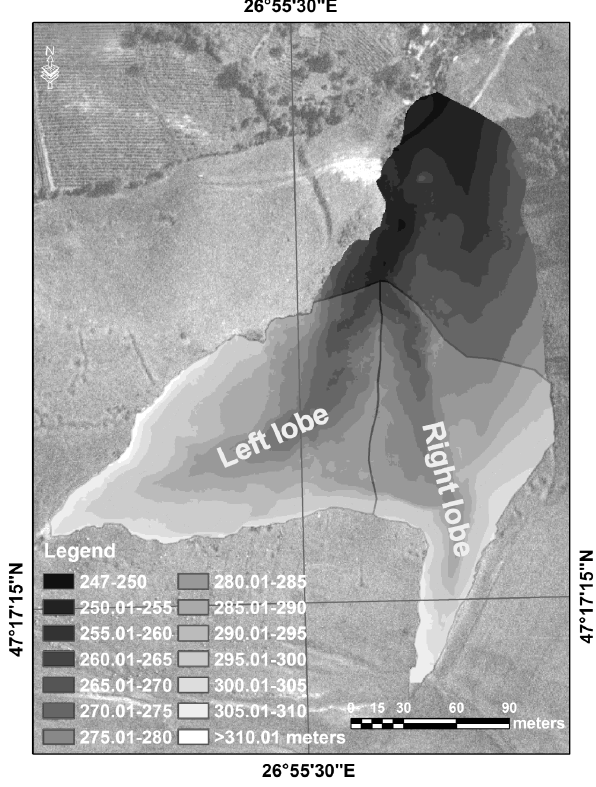
Fig. 20 Morphometric features of the Cucuteni-Baiceni gully Fig. 20. Morphometric features of the Cucuteni-Baiceni gully.